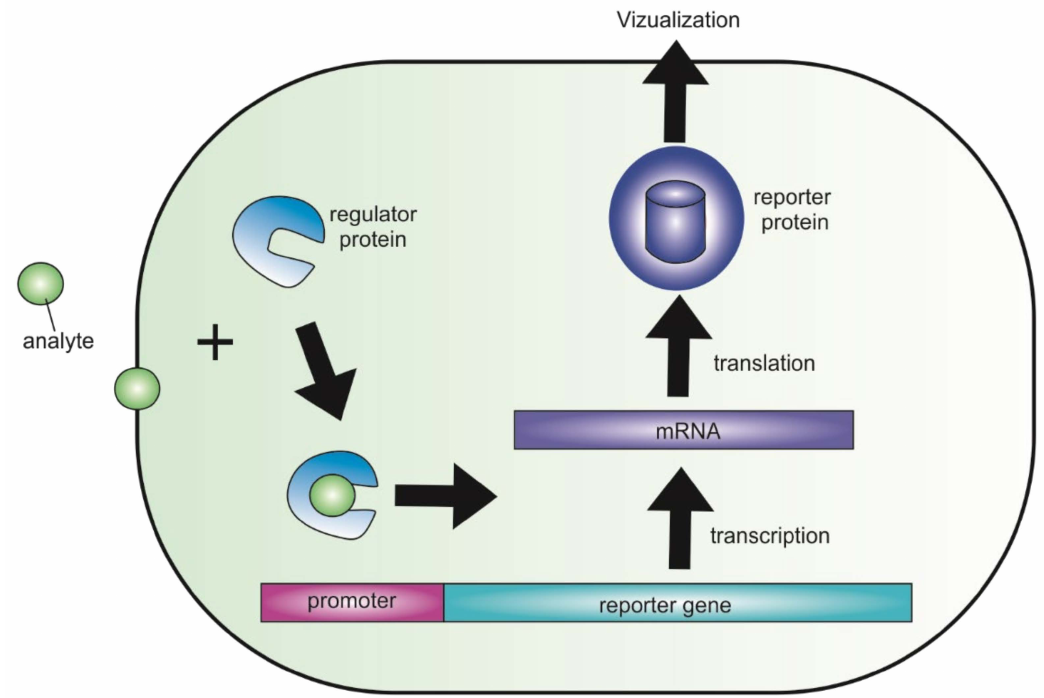
Figure 1. A schematic diagram that demonstrates how genetically encoded fluorescent biosensor works. An exogenous or endogenous analyte binds to a regulatory protein and changes gene expression. The altered expression can be further analyzed via analytical instruments (e.g., GFP can be detected with a fluorescent